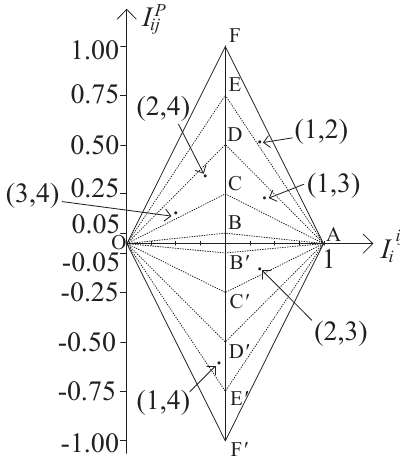
Figure 2. MCCPI of the four